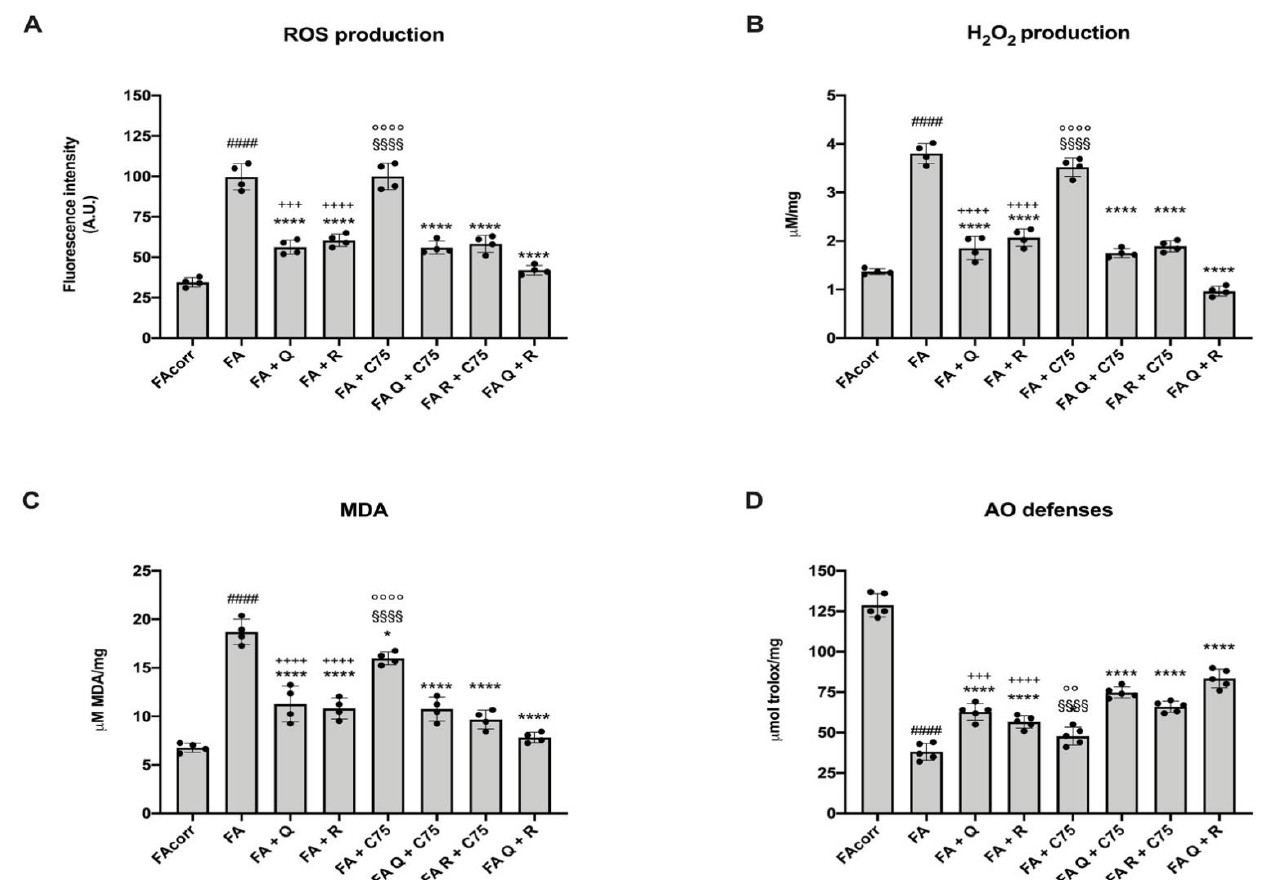
Figure 5. Modulation of oxidative stress production and antioxidant defenses in FA cells treated with quercetin, rapamycin, and C75, alone or in combination. All data represent experiments conducted after 48 h of drug treatments. ( A ) ROS production. ( B ) Hydrogen peroxide (H 2 O 2 ) production. ( C ) Malondialdehyde content as a marker of lipid peroxidation. ( D ) Total cellular antioxidant defenses. (Q = quercetin alone; R = rapamycin alone; C75 = C75 alone; Q + C75 = quercetin/C75 combination; R + C75 = rapamycin/C75 combination; Q + R = quercetin/rapamycin combination). Each graph represents four independent experiments and data are expressed as mean ± S.D. For FA and FA-corr cells, data are representative of four different Fanc-A lymphoblast cell lines. Statistical analysis was performed via one-way ANOVA followed by Tukey multiple comparison test. #### indicates a p < 0.0001 between FA cells and FA-corr cell lines. **** indicates a p < 0.0001 between untreated and treated FA cells. +++, or ++++ indicate a p < 0.001, or 0.0001, respectively, between treatment with quercetin or rapamycin alone and quercetin/rapamycin combination; §§§§ indicates p < 0.0001 between treatment with quercetin or C75 alone and quercetin/C75 combination; °°, or °°°° indicate a p < 0.01, or 0.0001, respectively, between treatment with rapamycin or C75 alone and rapamycin/C75 combination.